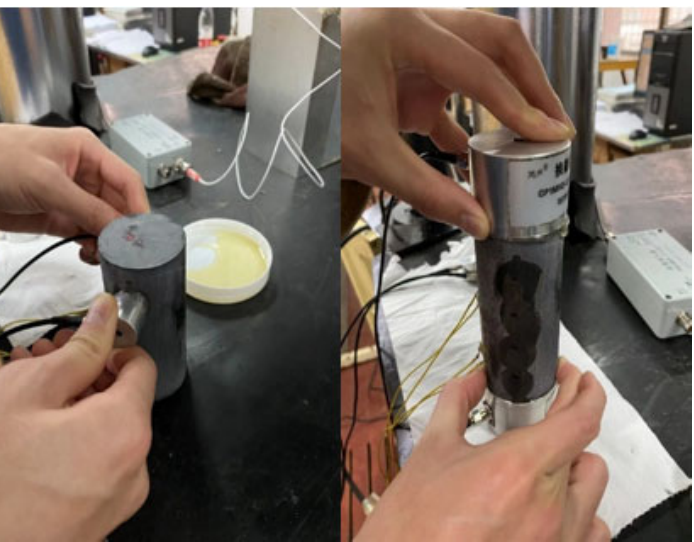
Figure 4. The radial and axial wave velocities of rock samples were collected during the test.